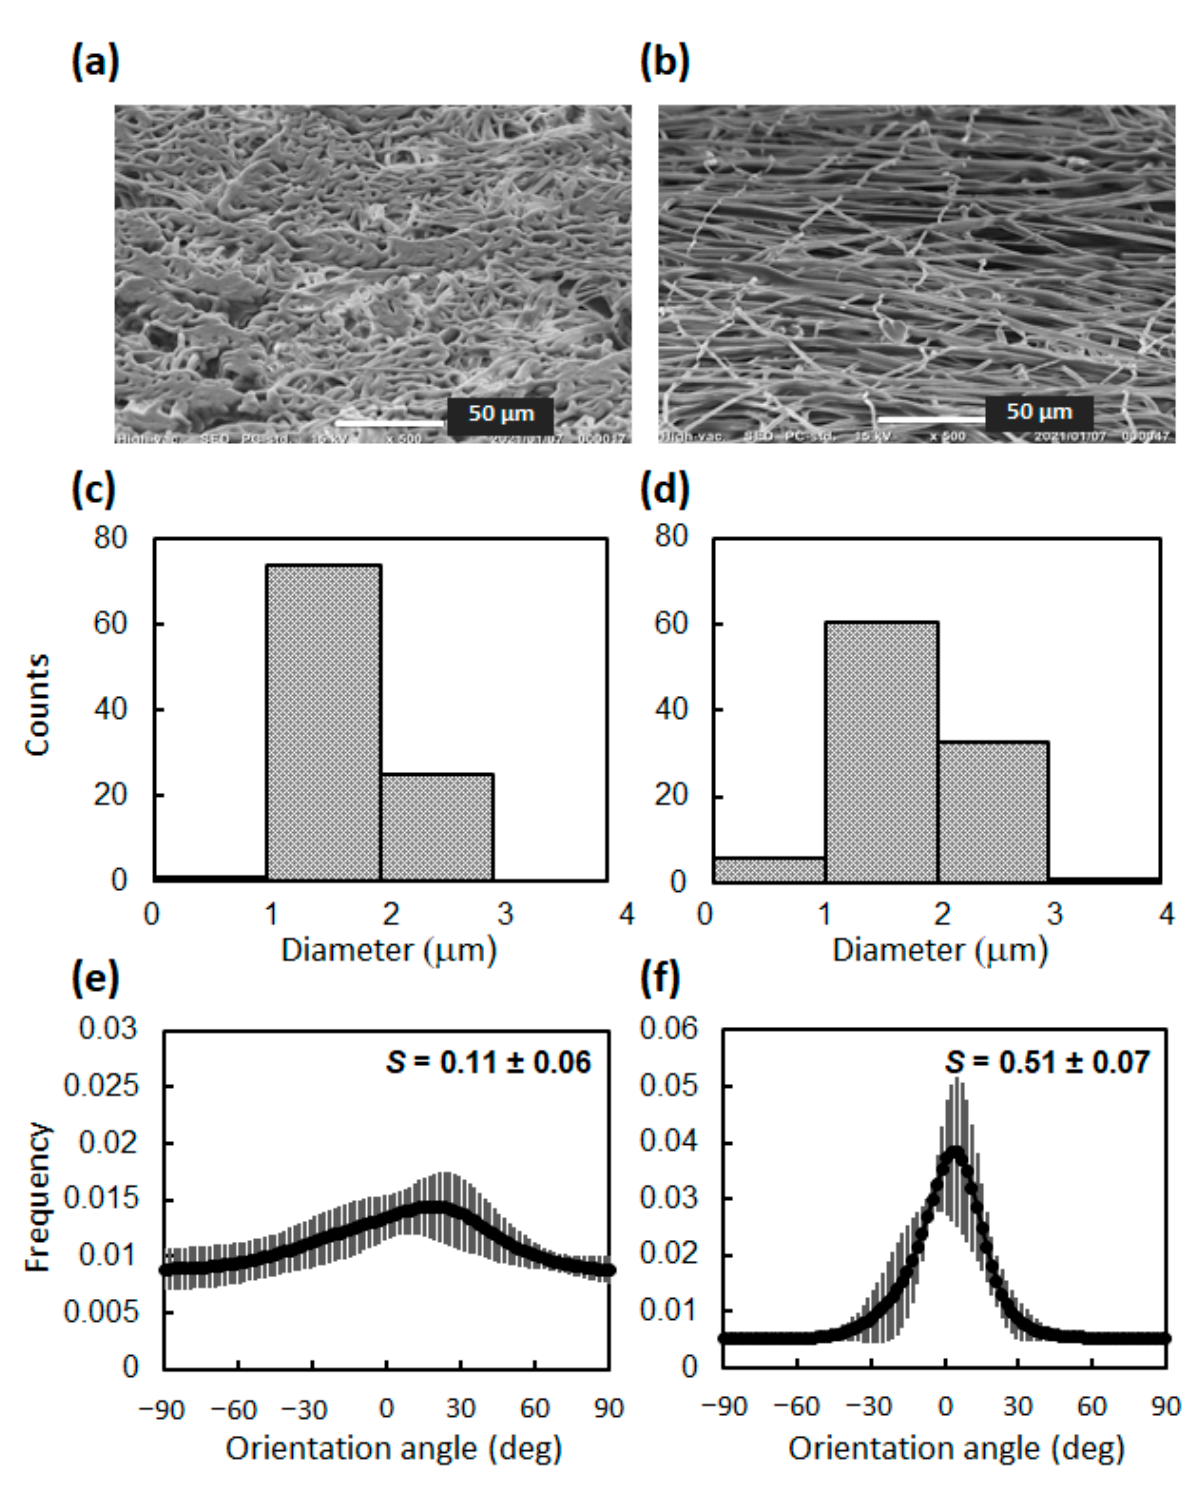
Figure 2. ( a,b ) SEM image, ( c,d ) fiber-diameter distribution, and ( e,f ) orientation distribution on the inner ( a,c,e ) and outer surface ( b,d,f ) of a nanofiber-m â ch é ball. The orientations of the inner (random) and outer (aligned) fibers were significantly